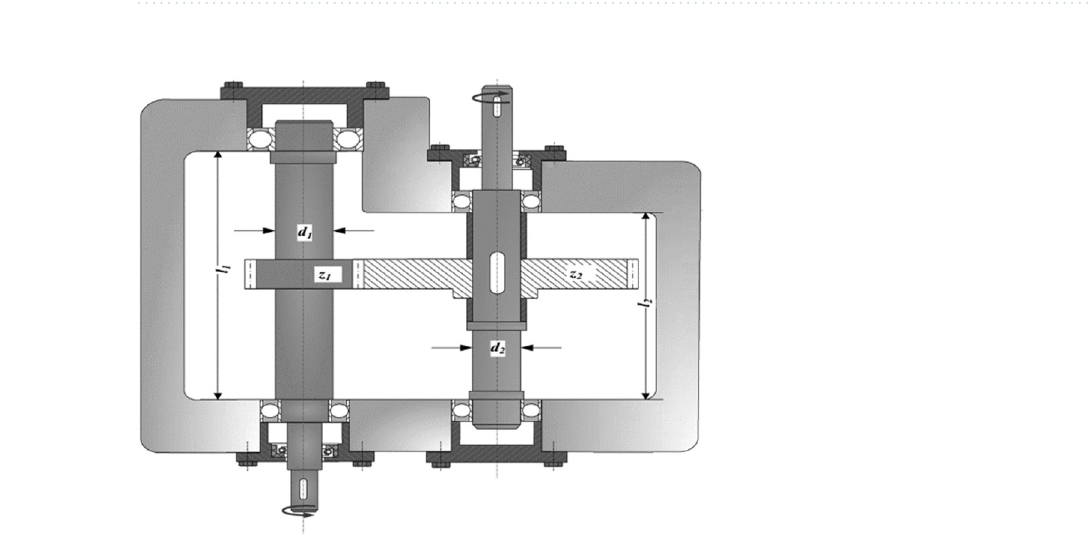
Figure 8. Schematic view of the speed reducer problem 66 .